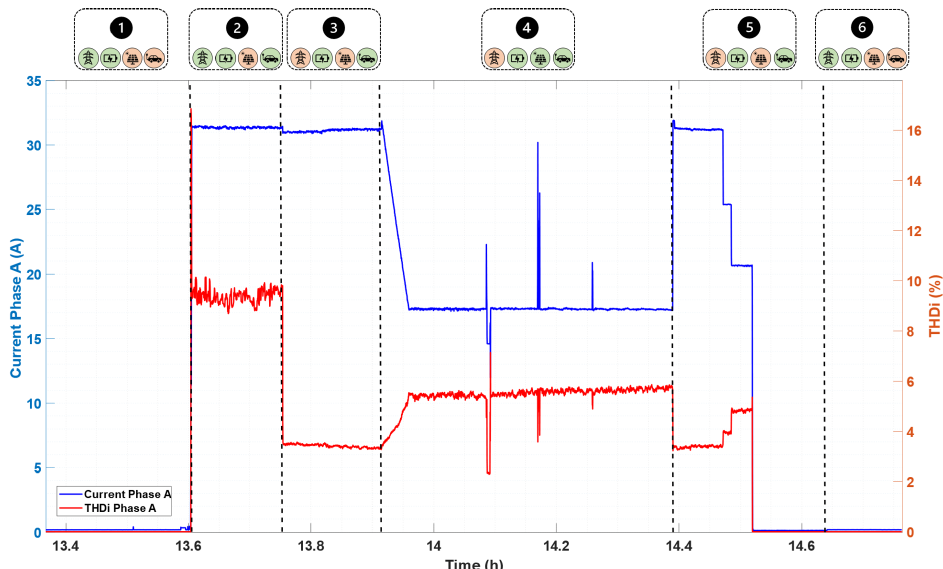
Figure 8. Current and current harmonic distortion of the system collected by power analyzer.